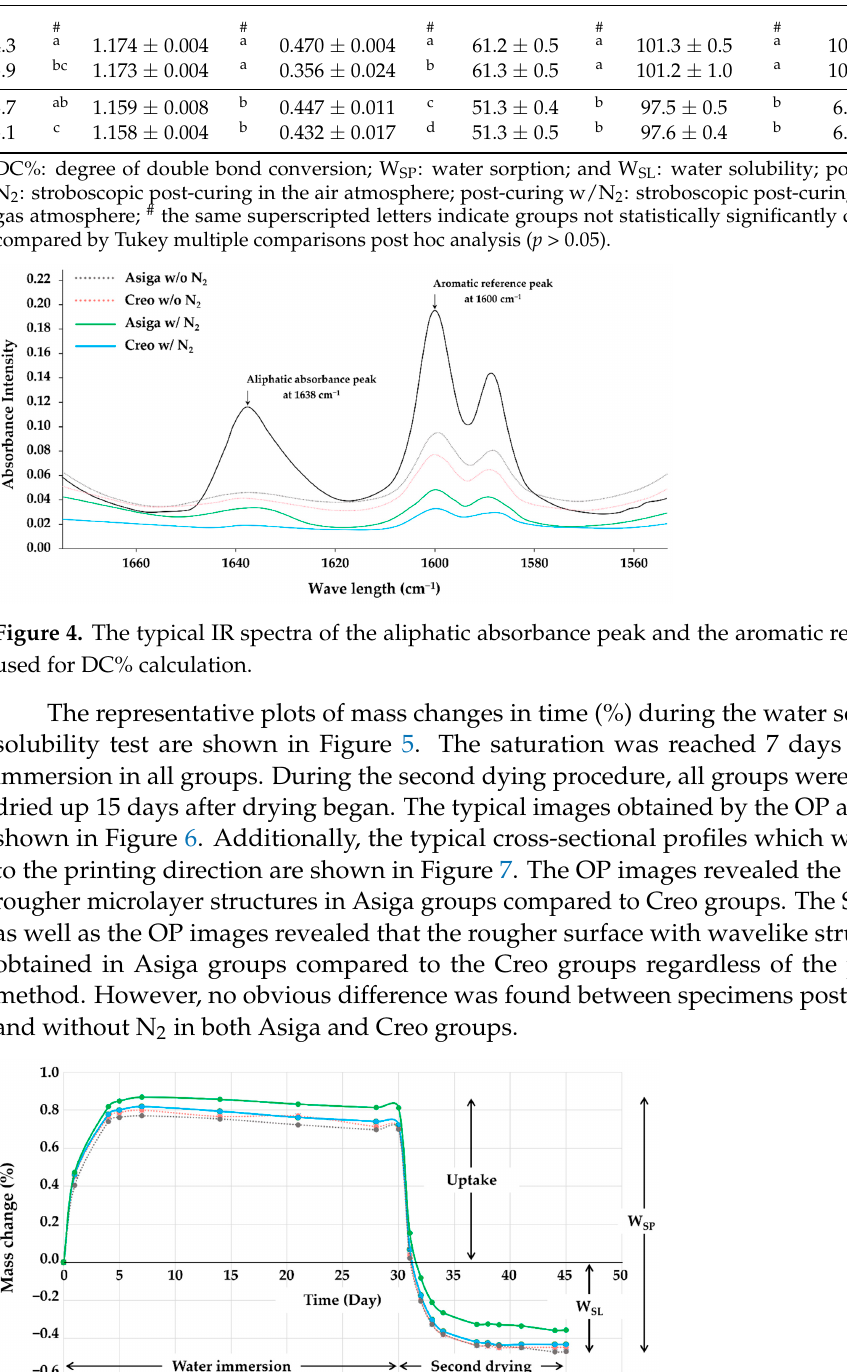
Figure 5. The representative plots of mass changes (%) against time during the water immersion and the second drying procedures. It was noted that saturation was achieved 7 days after water immersion and drying was completed 15 days after drying began in all groups.